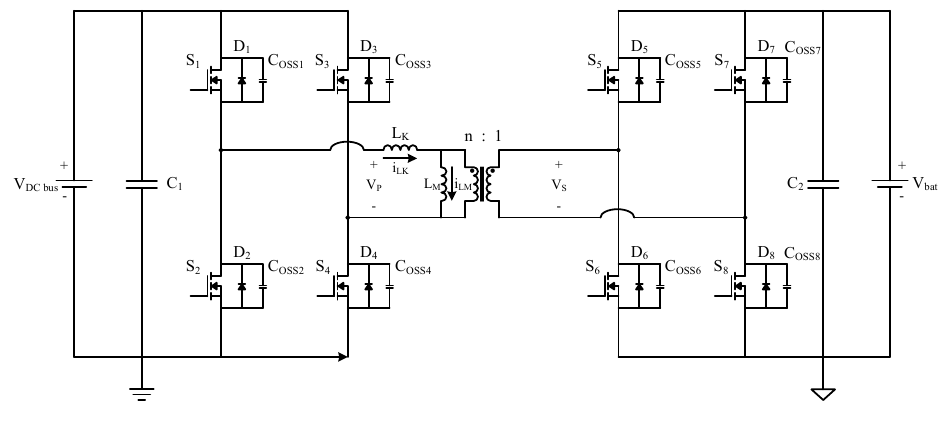
Figure 1. The DAB converter topology. There are numerous phase-shift control methods applied to DAB converters. Generally, they can be categorized as SPS control, extended-phase-shift (EPS) control, dual-phase-shift (DPS) control, and triple-phase-shift (TPS) control. Among these control methods, the SPS control method is the most widely used due to its advantages, such as ease of implementation, simple algorithms used, soft switching capabilities, etc. In the SPS control method, diagonally opposite switches on each full-bridge are controlled to create a leading or lagging phase of the primary side voltage relative to the secondary side voltage of the transformer to control power flow direction and magnitude. The phase difference between the voltages on the primary side V P and the secondary side V S , the so-called phase-shift angle, θ , is the only variable that can be controlled, as shown in Figure 2.